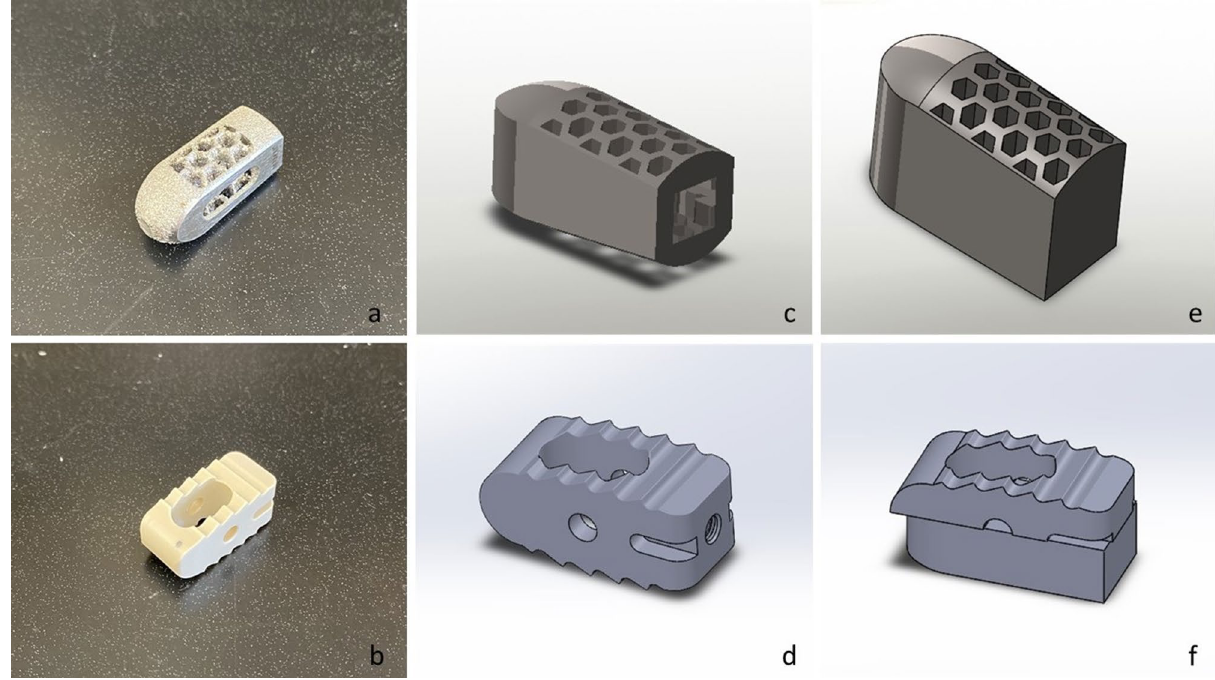
Figure 4. Images showing pictures of the original Fuse and Capstone cages ( a,b ), their full implant CAD models ( c,d ), and the CAD models used for the biomechanical testing ( f,g ).